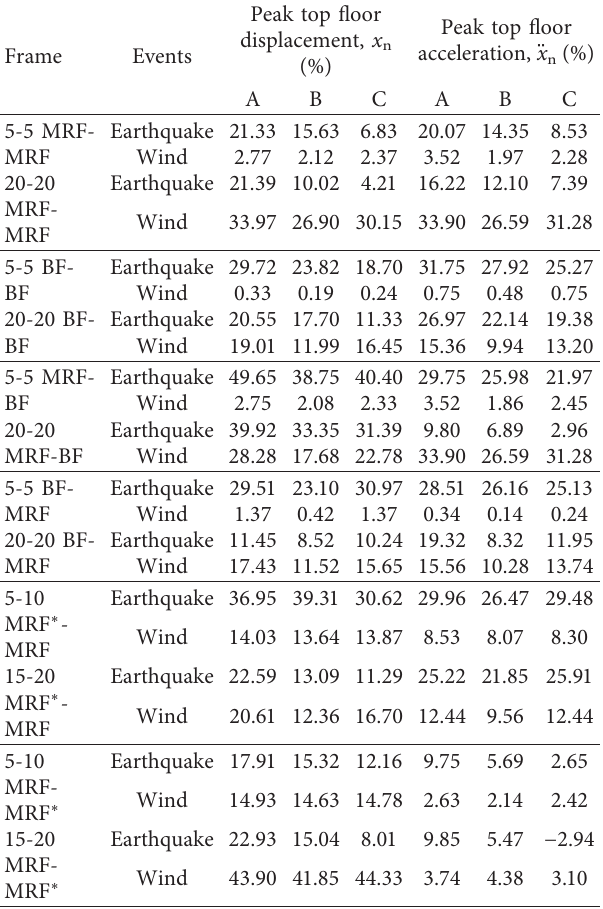
Table 12: Effectiveness of the FDs for different configurations of the connected dynamic similar and dissimilar steel buildings under earthquake ground motions and gust wind